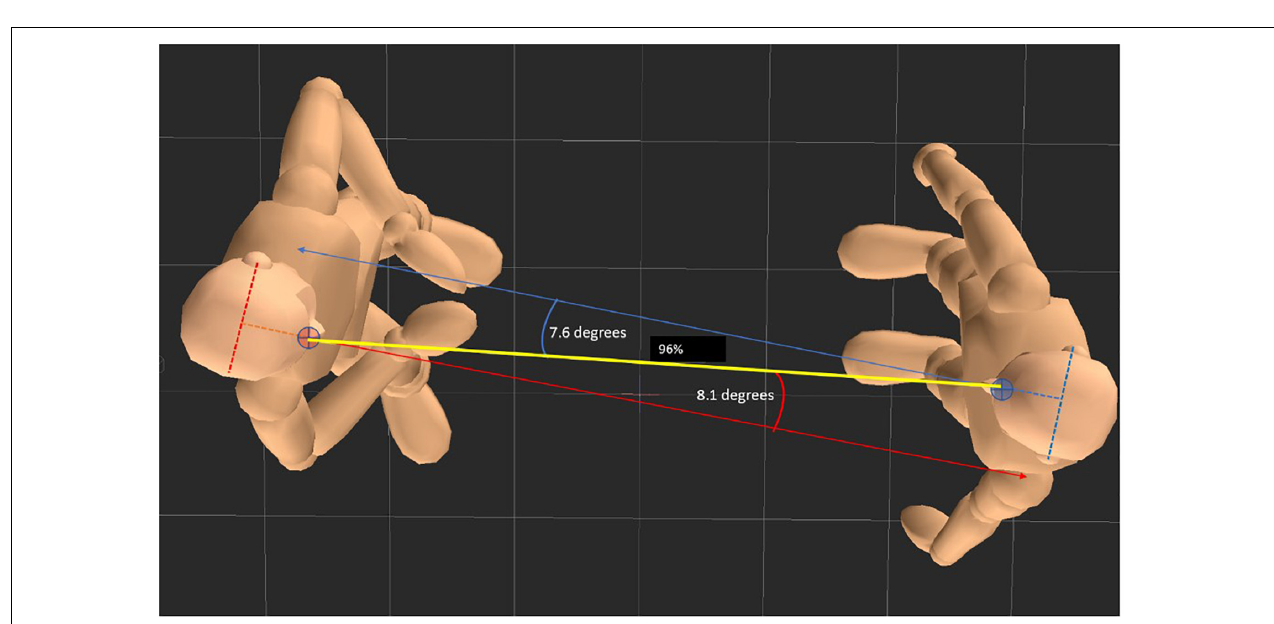
FIGURE 5 | Interaction graph for rapport ratings (estimated marginal means) depending on gender and culture of the stimulus dyads. The y -axis scale is set from –1 to +1 here to showcase the effect (the participants rated from –4 to +4).